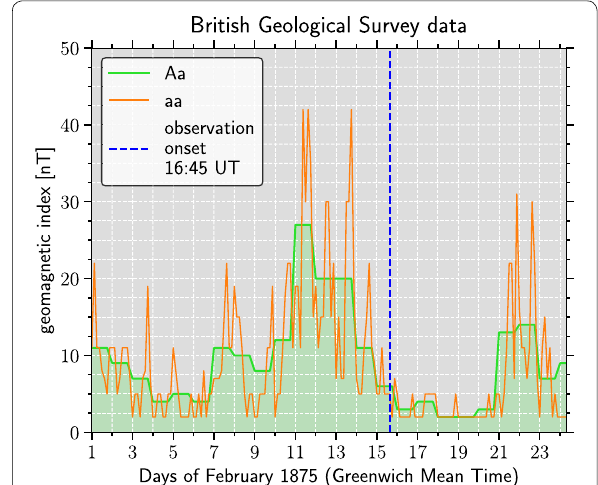
Fig. 3 British Geological Survey 3-h aa index (solid orange line) and the 24-h Aa index (solid green line/shaded green area) for the interval 1–24 February 1875. The dashed blue line indicates the onset of the aurora observation (15 February 1875 at 19:45 LMT/16:45 GMT) reported by Emmanuel Liais to the Jornal do Commercio